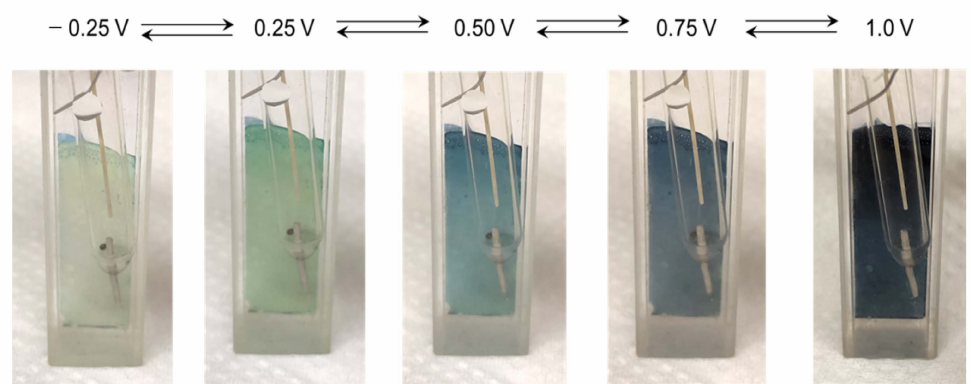
Figure 16. Change in color of electrochemically prepared fucoidan/E-PANI(gel) film deposited on indium tin oxide (ITO)-coated glass upon application of voltage between − 0.25 V and 1.0 V in 0.1 M TBAP/acetonitrile solution.